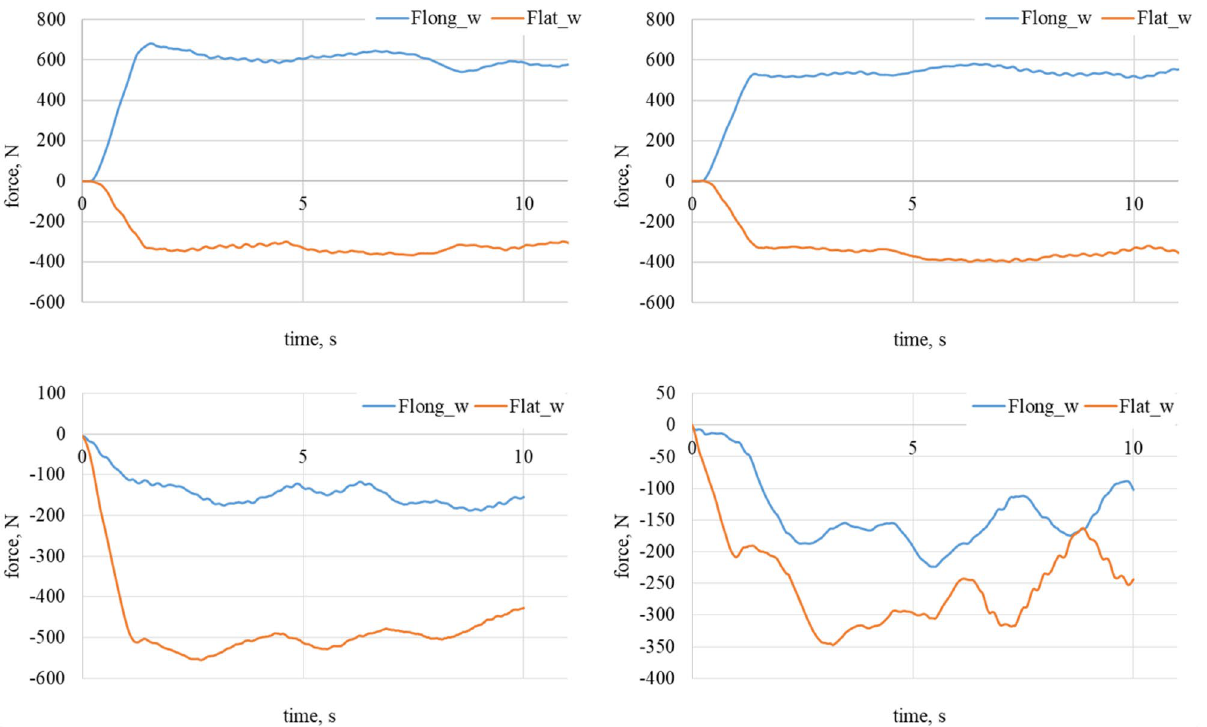
Figure 7. Longitudinal and lateral forces related to the wheel geometry for α w = 60°. On the top left waveform: dry granite; on the top right waveform: wet granite. On the bottom left waveform: loose snow; on the bottom right waveform: compacted snow.